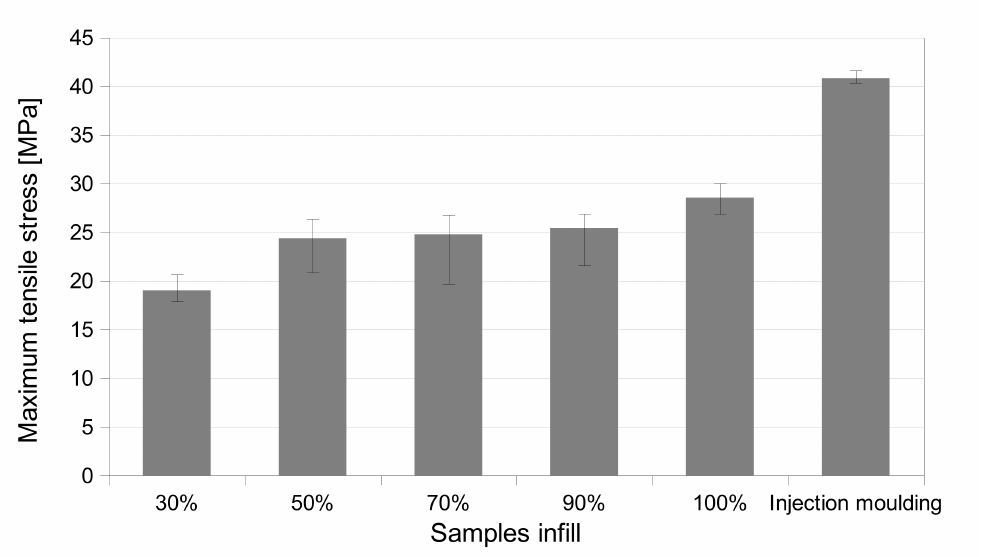
Figure 7. The influence of the infill density of printed samples on their mechanical properties. The effect of infill density and the number of contour layers on the “flat” printed samples are compared in Figure 8. We can observe a significant influence of the contour on the infill inside the printed samples, which is illustrated in Figures 3 and